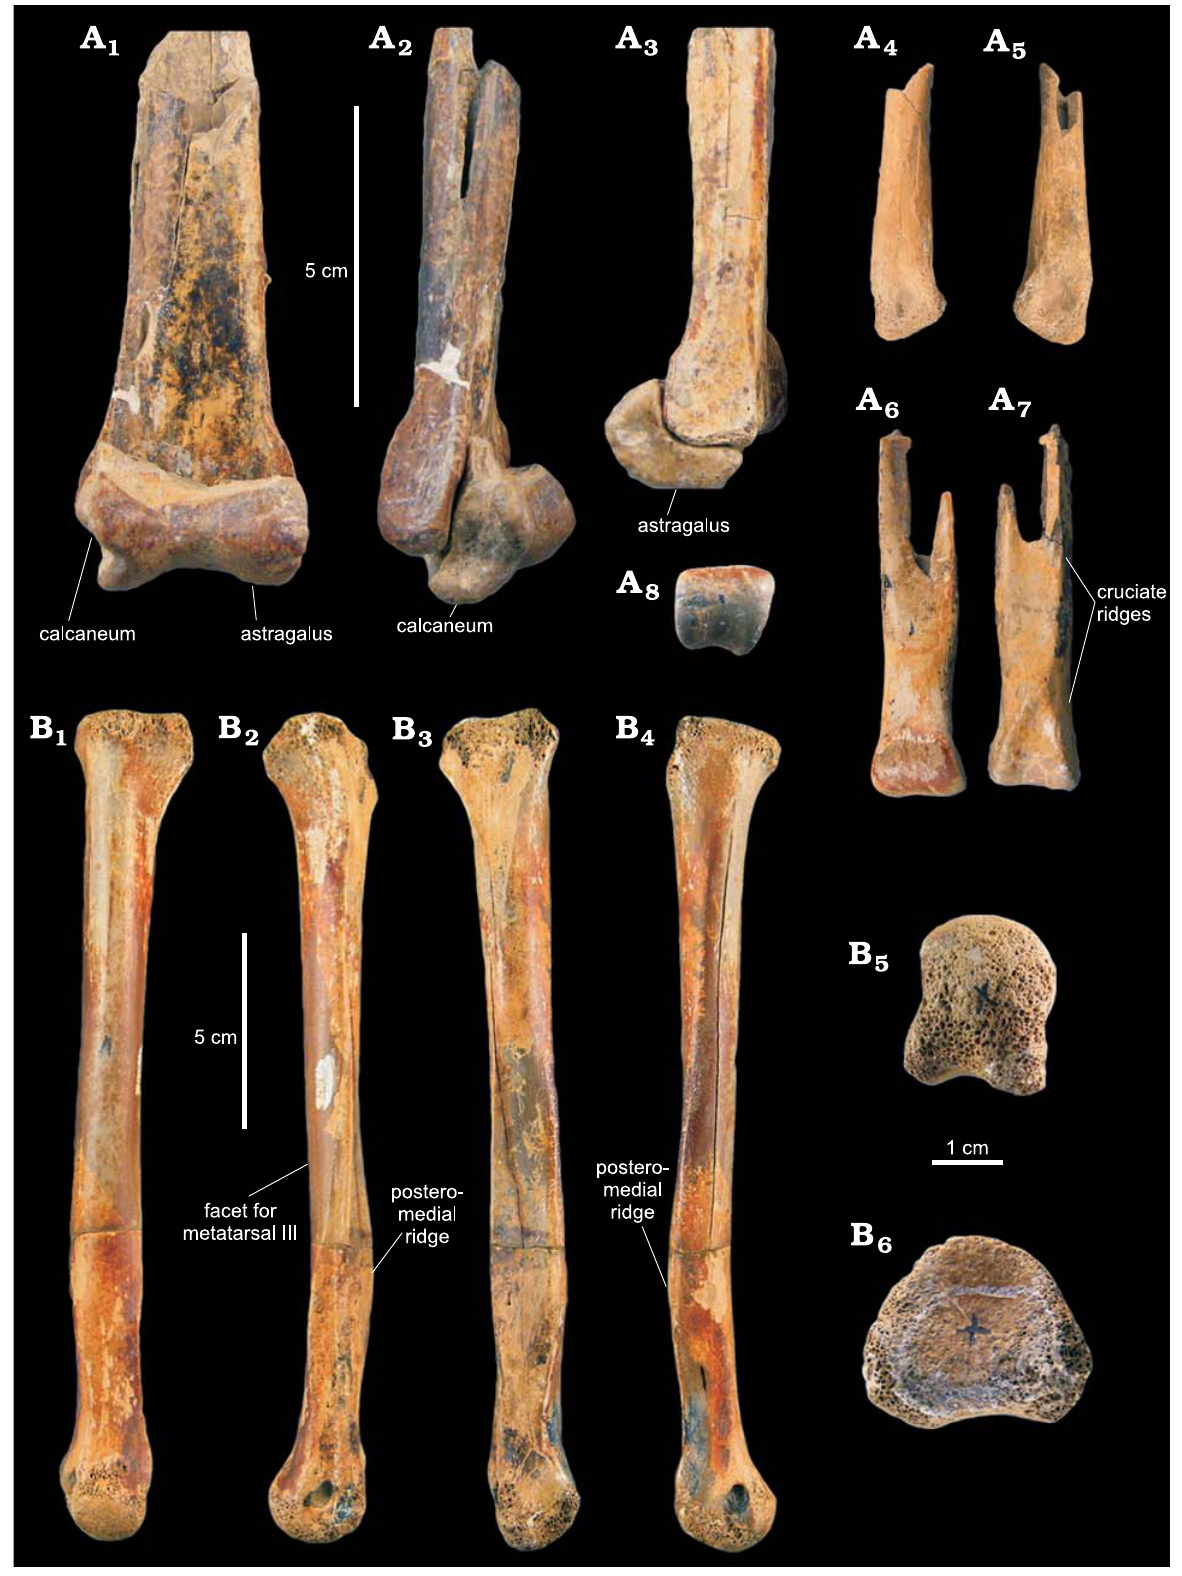
Fig. 10. Elmisaurine dinosaur Leptorhynchos sp. from Upper Maastrichtian Frenchman Formation, Saskatchewan, Canada. A . RSM P2600.1, distal por- tion of left tibia and astragalocalcaneum in posterior (A 1 ), lateral (A 2 ), and medial (A 3 ) views; distal portion of right second metatarsal in anterior (A 4 ) and posterior (A 5 ) views; distal portion of third metatarsal in anterior (A 6 ), posterior (A 7 ), and distal (A 8 ) views. B . RSM P2161.1, left second metatarsal in anterior (B 1 ), medial (B 2 ), posterior (B 3 ), lateral (B 4 ), distal (B 5 ), and proximal (B 6 )